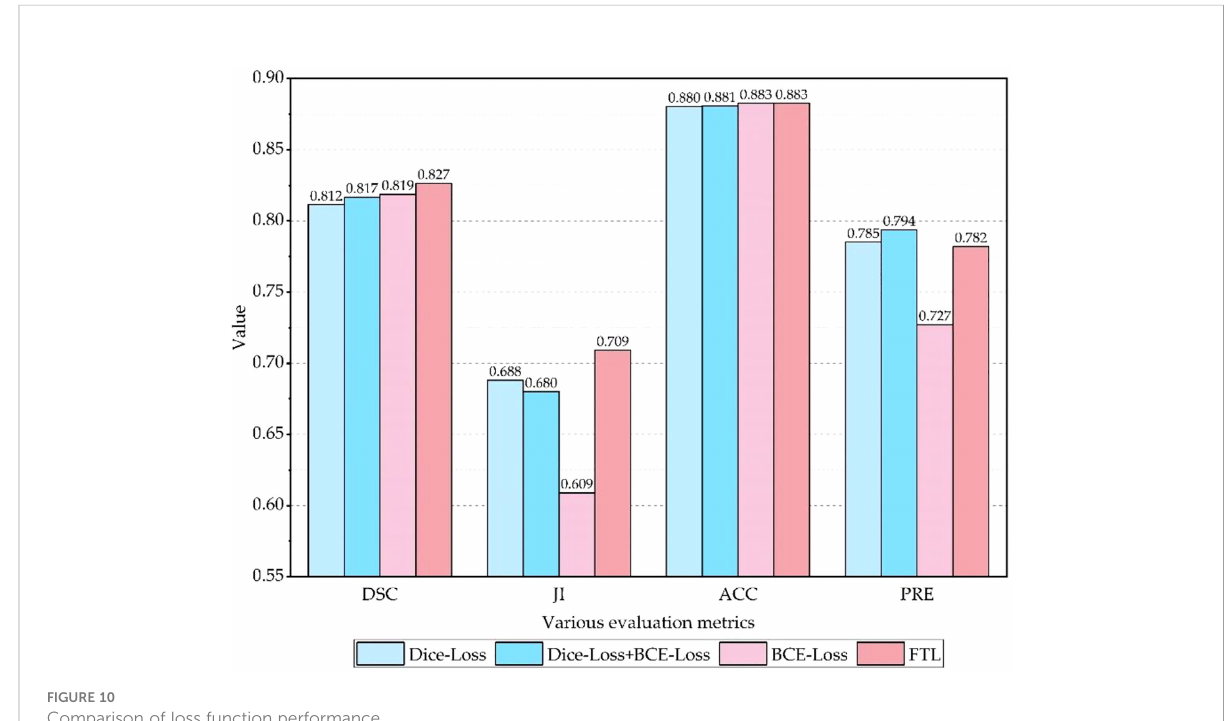
FIGURE 10 Comparison of loss function